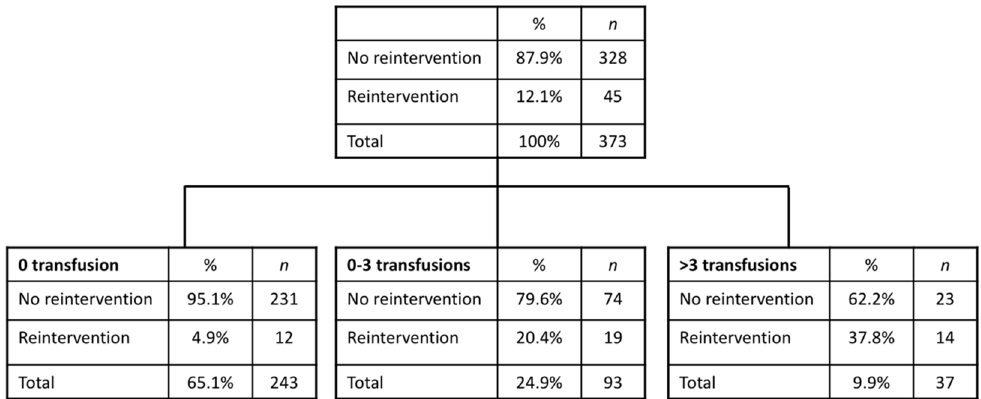
Figure 3. Recursing partitioning analysis (RPA) was used to create a regression tree according to reoperation rates and transfusion.